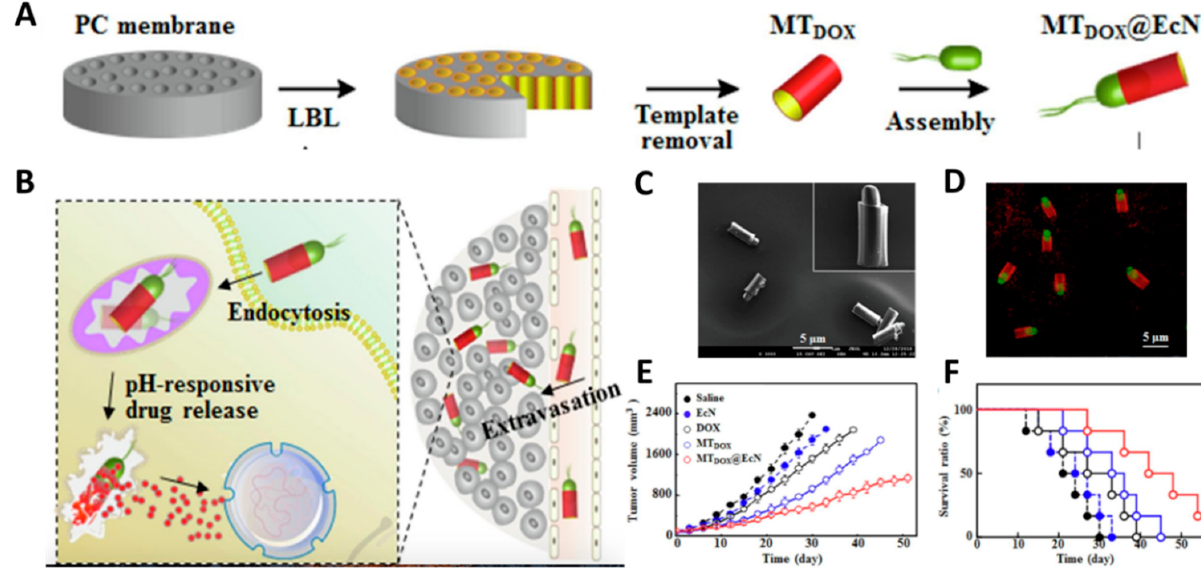
Figure 3. ( A ) Schematic illustration of the synthesis of MT dox @EcN; ( B ) Schematic illustration of the mechanism of MTDOX@EcN as a biorocket for drug delivery in tumor; ( C ) Typical SEM and ( D ) CLSM images of MTDOX@EcN. ( E ) Tumor inhibition and ( F ) survival rates of MT dox @EcN treatment in tumor-bearing mice. Reproduced with permission from Xiaohong Li, Chemical Engineering Journal; published by Elsevier, 2020.